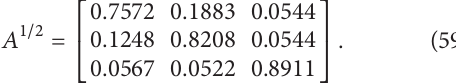
Algorithm 6( b ) is not stable: it converges to the right value of